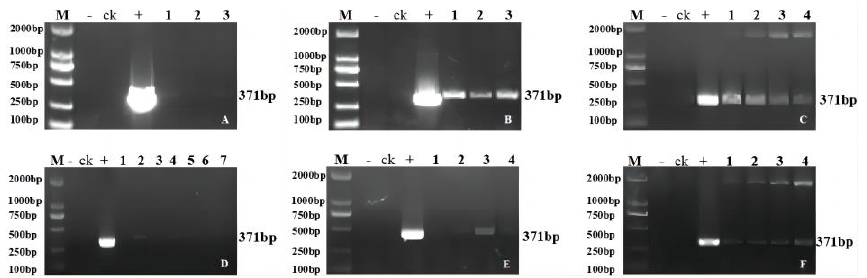
Figure 2. PCR detection of Cas9 in some T 1 generation transgenic plants: ( A ) 1–3 transgenic positive plants; ( B ) 1–3 transgenic positive plants; ( C ) 1–4 transgenic positive plants; ( D ) 1–7 transgenic positive plants; ( E ) 1–4 transgenic positive plants; ( F ) 1–4 transgenic positive plants. M: DL2000 DNA marker; +: positive plasmid; -: negative control.